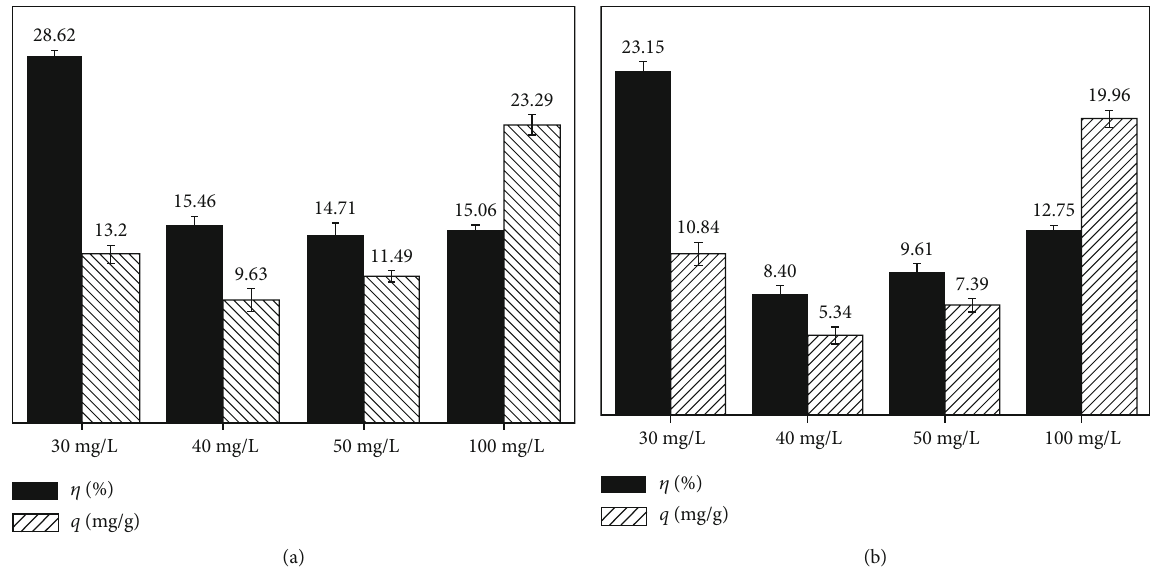
Figure 5: Desalination e ff ect of the electrosorption of the synthesized UiO-66 samples, at di ff erent concentrations of the sodium dihydrogen phosphate solution ((a) UiO-66 (acetic acid); (b) UiO-66 (hydrochloric acid)). Table 2: Total phosphorus concentration of the electrosorption of the synthesized UiO-66 samples, for di ff erent concentrations of the sodium dihydrogen phosphate solution.